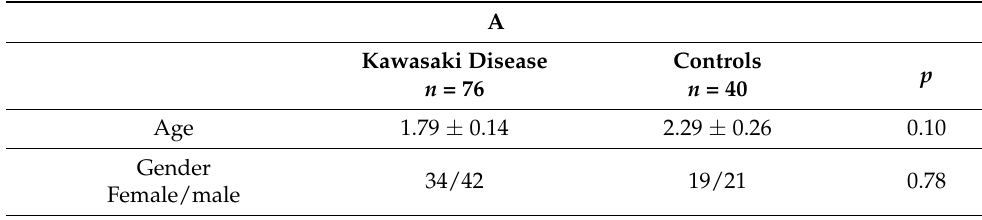
Table 1. ( A ) Basal characteristics of patients with Kawasaki disease and controls. ( B ) Characteristics of